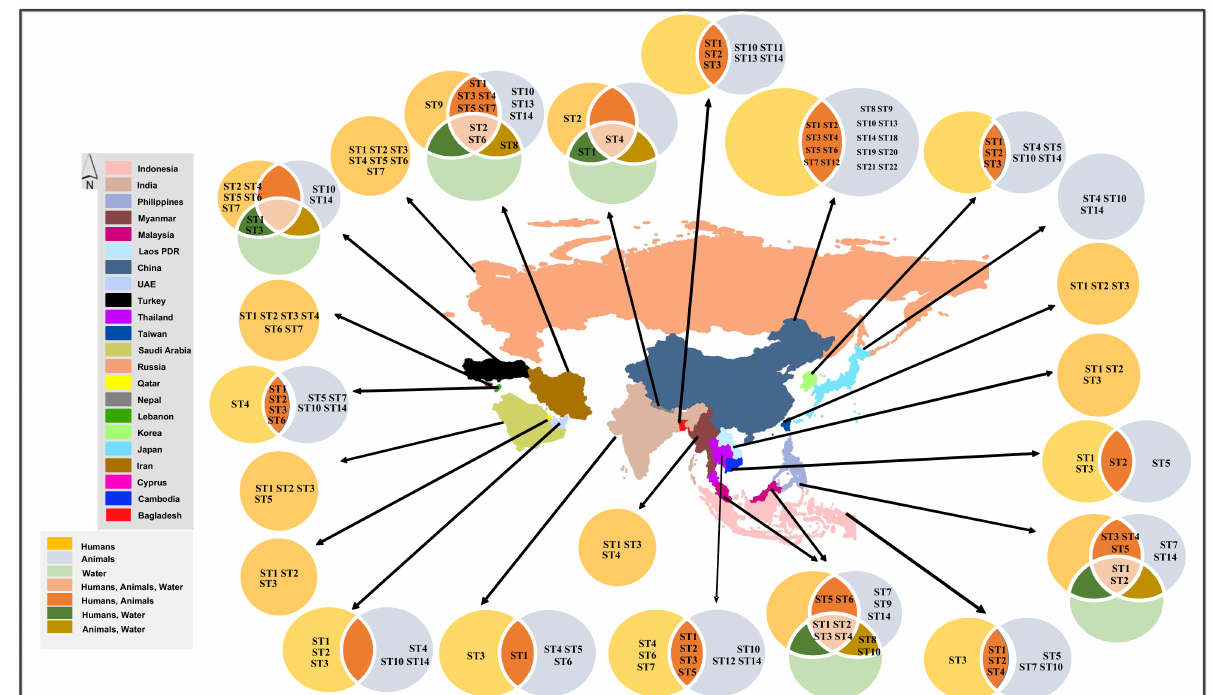
Figure 1. Distribution of Blastocystis spp. subtypes in Asia